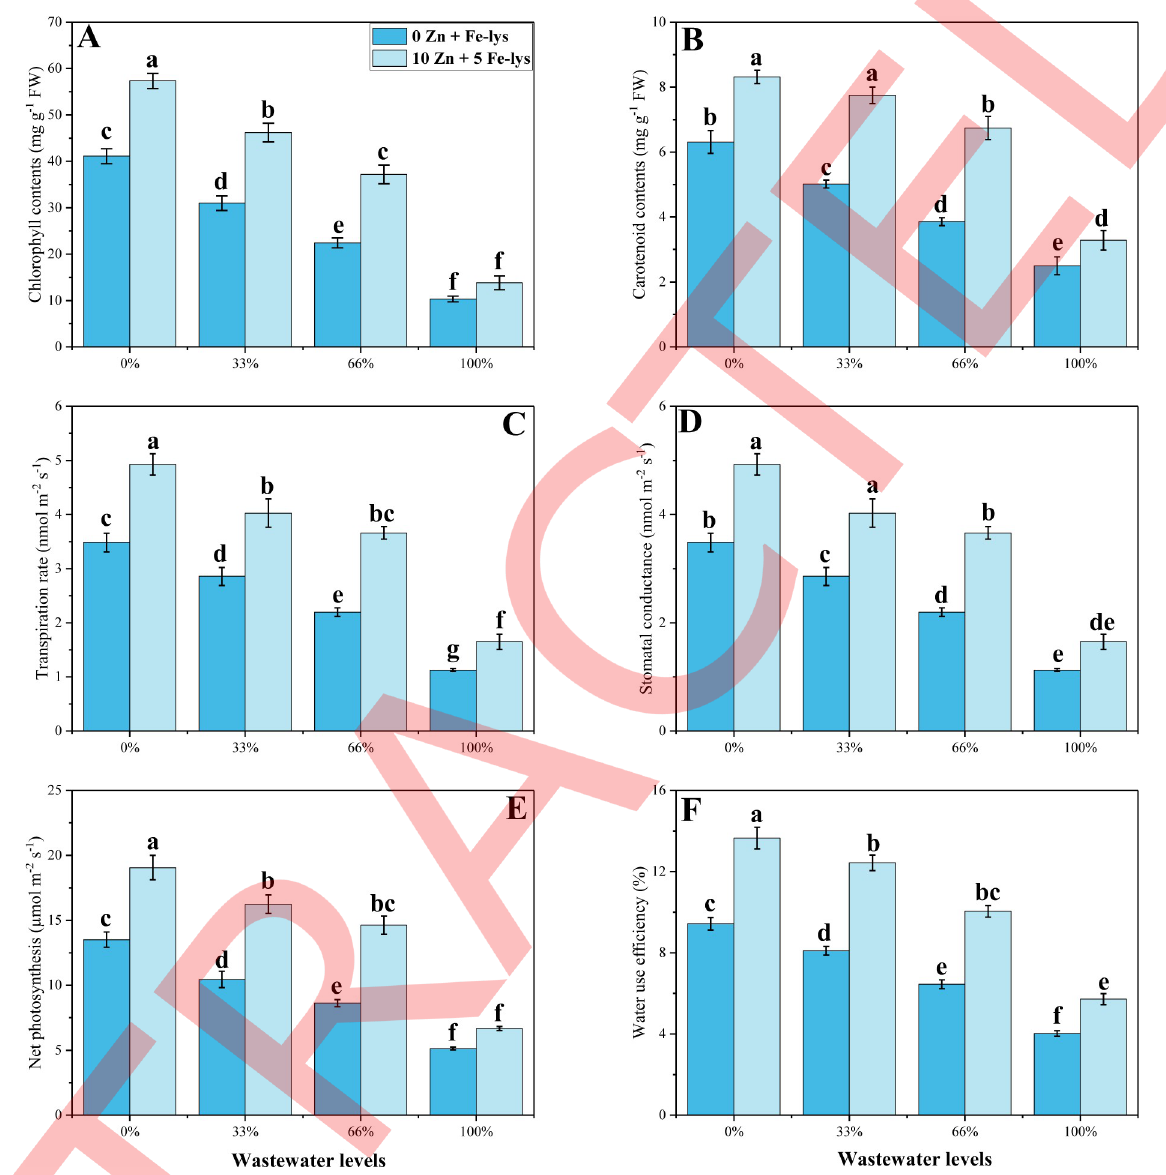
Fig 2. Effect different levels of tannery wastewater on chlorophyll contents (A), carotenoid contents (B), stomatal conductance (C), transpiration rate (D), net photosynthesis (E) and water use efficiency (F) under the application of Zn and Fe-lys on B . napus . Values are demonstrated as means of three replicates along with standard deviation (SD; n = 3). One-way ANOVA was performed and means differences were tested by HSD ( P < 0.05). Different lowercase letters on the error bars indicate significant difference between the treatments. Different levels of tannery wastewater used are as follow: 0 (without irrigation with wastewater), 33 (33% irrigation with wastewater), 66 (66% irrigation with wastewater) and 100 (100% irrigation with wastewater).